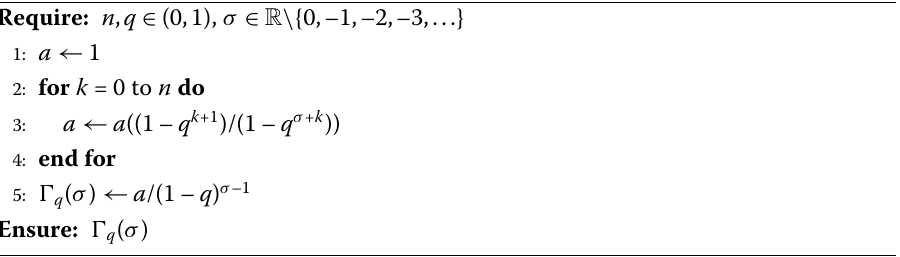
Algorithm 1 The pseudo-code to compute different values of (cid:9) q ( σ )